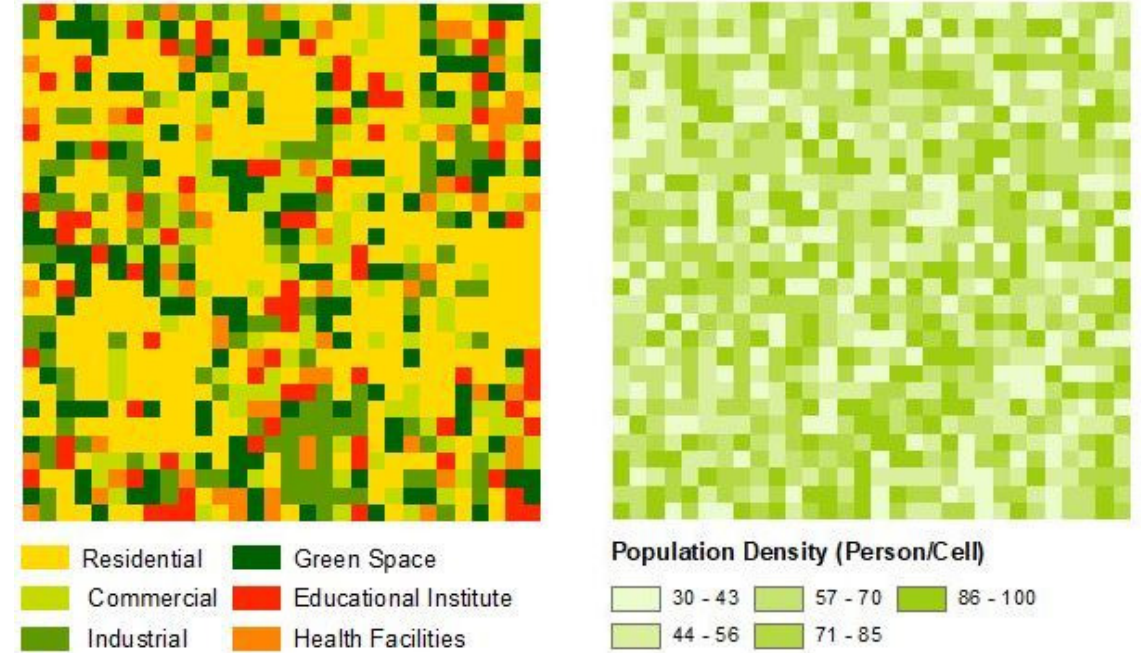
Figure 2. Hypothetical land use ( left ) and population ( right ) data used in this study.